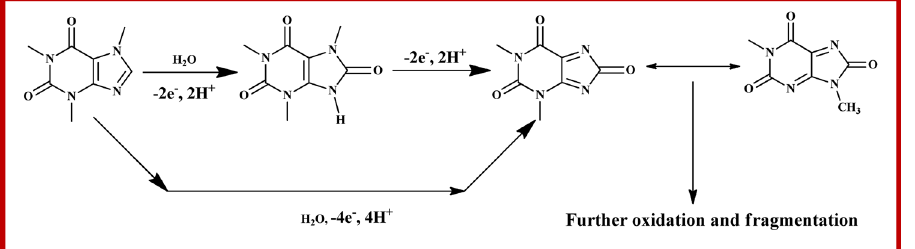
Figure 6. Mechanism of the electrochemical oxidation of caffeine at NAHGO.